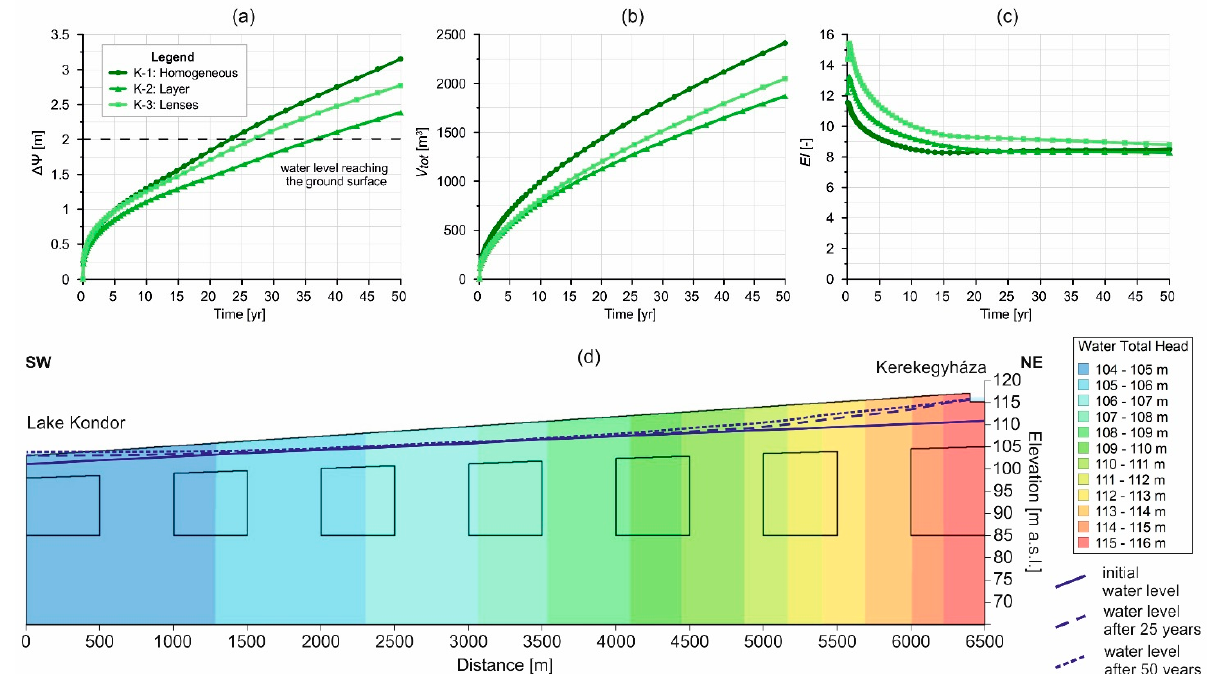
Figure 9. ( a ): Water level increase ( ΔΨ ), ( b ): cumulative water volume infiltrating from the infiltration basin ( V tot ) and ( c ): the Efficiency Index ( EI ) in time. ( d ): Initial water level and water level increase for the case study cross-section after 25 and 50 years (K-3). The hydraulic head ( h ) contours represent the last step of the model (after 50 years). The vertical exaggeration is 1:30.